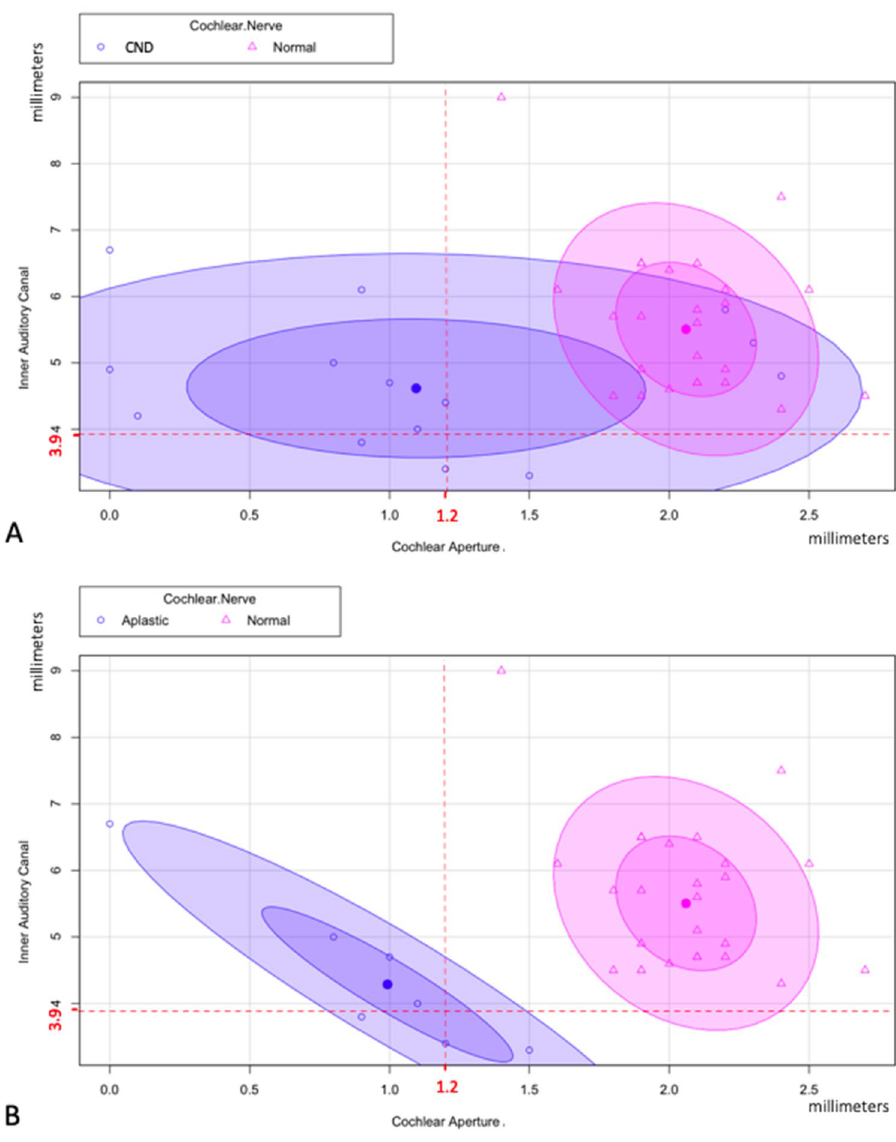
Figure 3. Dispersion graphs 35 of IAC and CA measures, indicating that the size of CA is a more accurate indicator of CND, especially in case of cochlear nerve aplasia. A . Comparison between the affected ears with CND (aplasia and hypoplasia, 14 cases, blue area) and affected ears with normal cochlear nerve (25 cases, pink area). CA measures are represented on x-axis, while the IAC measures are represented in the y-axis. The cut offs to define the IAC or CA stenosis are indicated in red. The central point of the blue area represents the average dimensions of IAC and CA in patients with CND (IAC = 4.7 mm, SD = 1.2; CA = 1.2 mm, SD = 0.7), while the central point of the pink area represents the average dimensions of the same parameters but in patients with normal CN (IAC = 5.6 mm, SD = 1.1; CA = 2.1 mm, SD = 0.7). For both areas, the internal ellipse represents 1 standard deviation, while the external one represents 2 standard deviations. B . The blue area focuses on CND cases with nerve aplasia 7 , after exclusion of hypoplasia cases (central point: IAC = 4.4 mm, SD = 1.1; CA = 0.9 mm, SD =